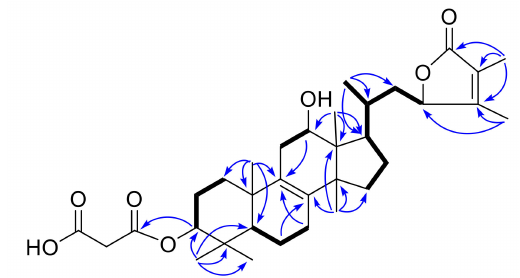
Figure 3. Key 1 H − 1 H COSY ( — ) and selected HMBC correlations (H → C) of 4